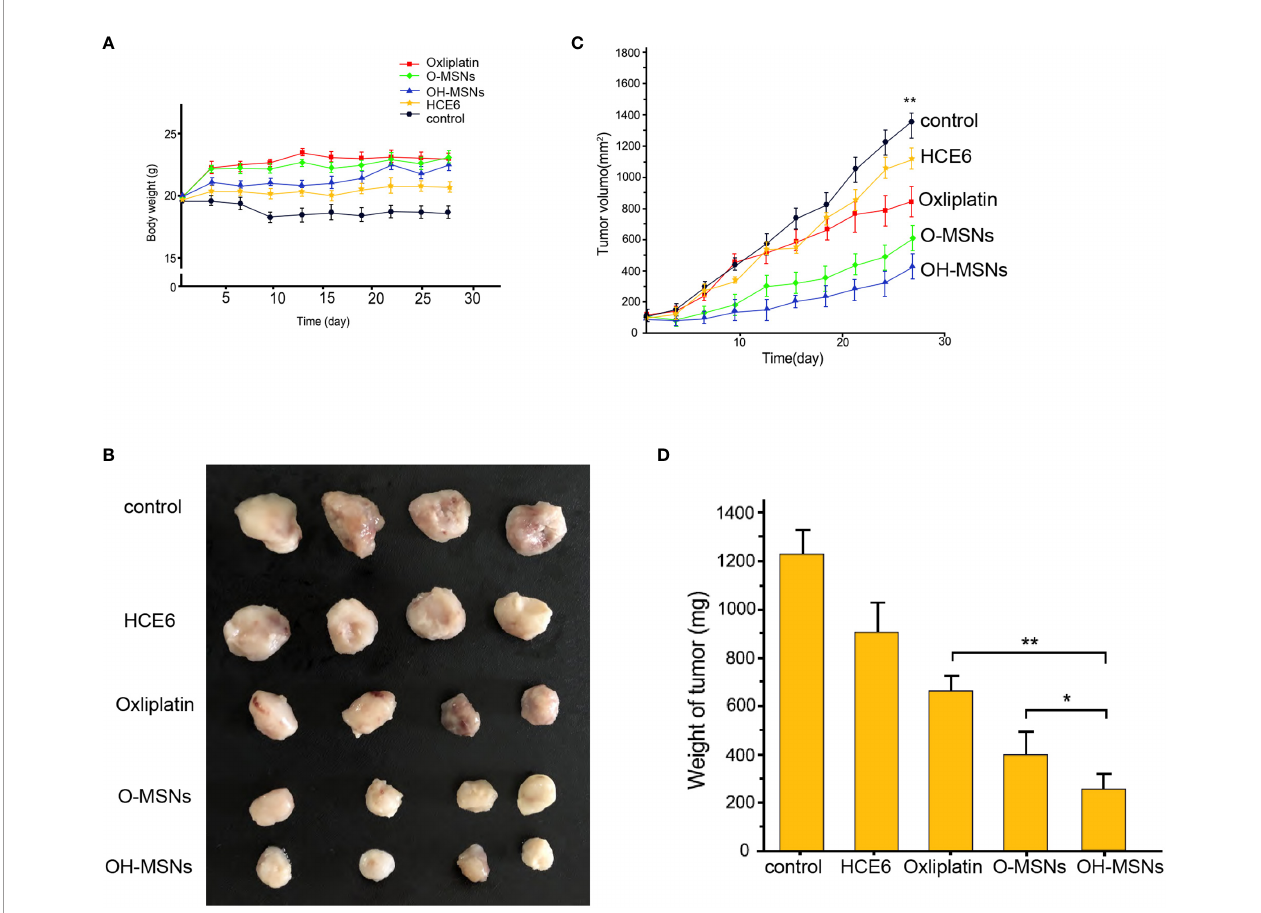
FIGURE 7 | Tumor growth in mice. (A – D) The nude mice (n=4) were injected with FRH0201 cells and were treated as the indicated labeling. (A) The body weight was remarketed. (B) The tumor size was shown. (C) The tumor volume was shown. (D) The tumor weight was shown. Data are presented as mean ± SD. Statistic signi fi cant differences were indicated: *P < 0.05, **P <